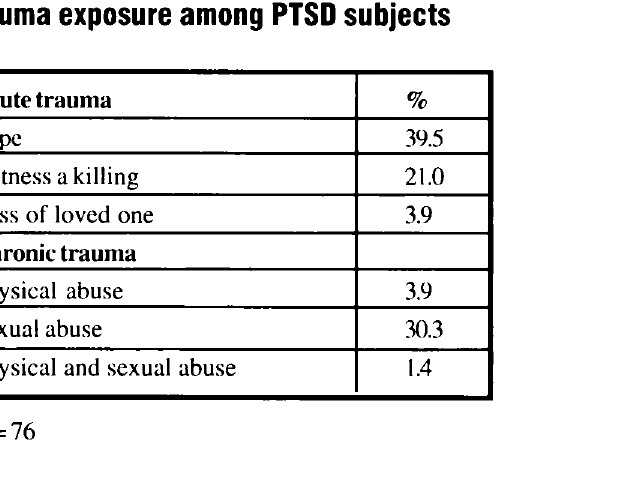
Trauma exposure among PTSD subjects